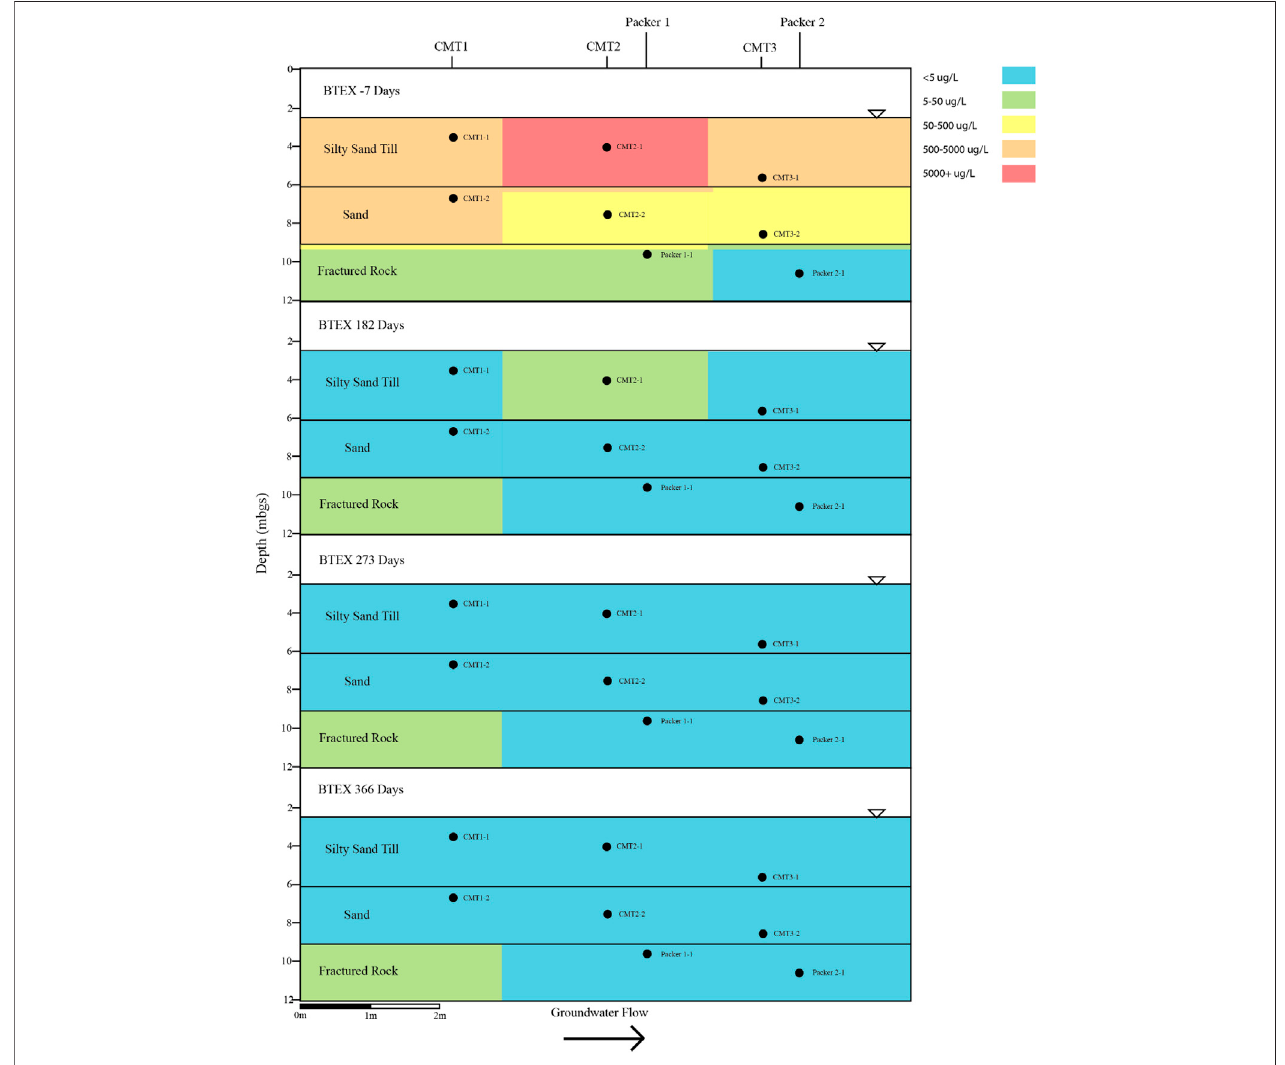
FIGURE 8 | Cross sectional view of BTEX groundwater concentrations determined on pre- and post-injection of the CAC within the three aquifers.